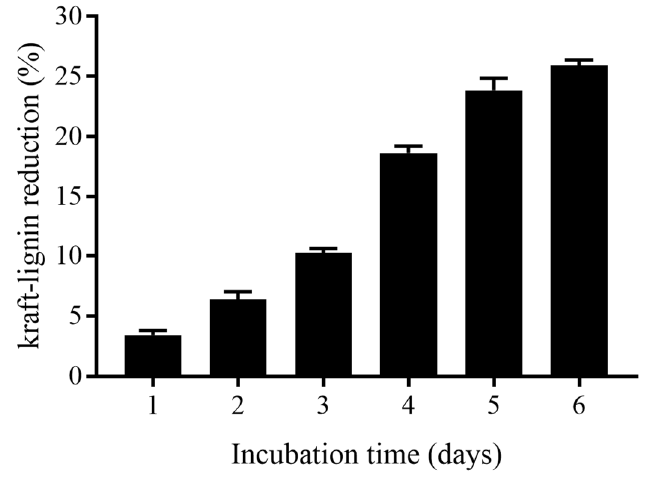
Figure 7. Kraft-lignin reduction.